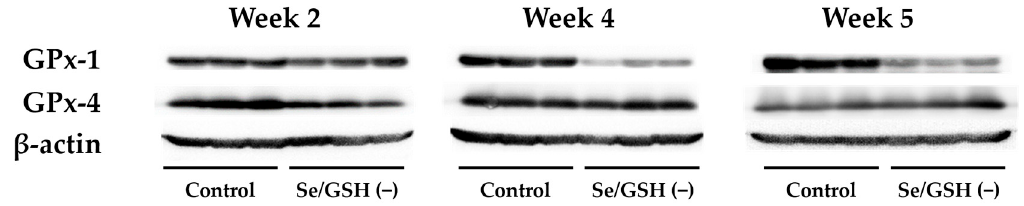
Figure 3. The protein expression of hepatic GPx-1 and 4 in the control and Se / GSH-depleted rats. Hepatic protein expression of GPx-1 (22 kDa), GPx-4 (22 kDa) and β -actin (45 kDa) are presented ( n = 3 / sampling points). Se / GSH ( − ): Se / GSH-depleted group.